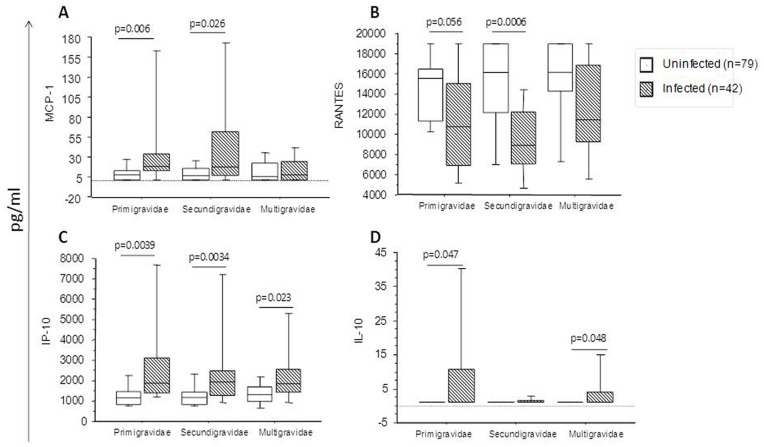
Comparison of inflammatory factors in peripheral plasma from P. falciparum infected and uninfected women stratified by gravidity status.Plasma levels of (A) MCP-1 (B) RANTES, (C) IP-10 and (D) IL-10 according to gravidity of the women. Infected primigravidae (n = 12), uninfected primigravidae (n = 22), infected secundigravidae (n = 17), uninfected secundigravidae (n = 33), infected multigravidae (n = 13) and uninfected multigravidae (n = 25). The boxes represent the values between 25% and 75% quartile and the line indicates the median. The whiskers indicate the 10% and 90% percentiles. P-values were determined by non-parametric Mann-Whitney U test.